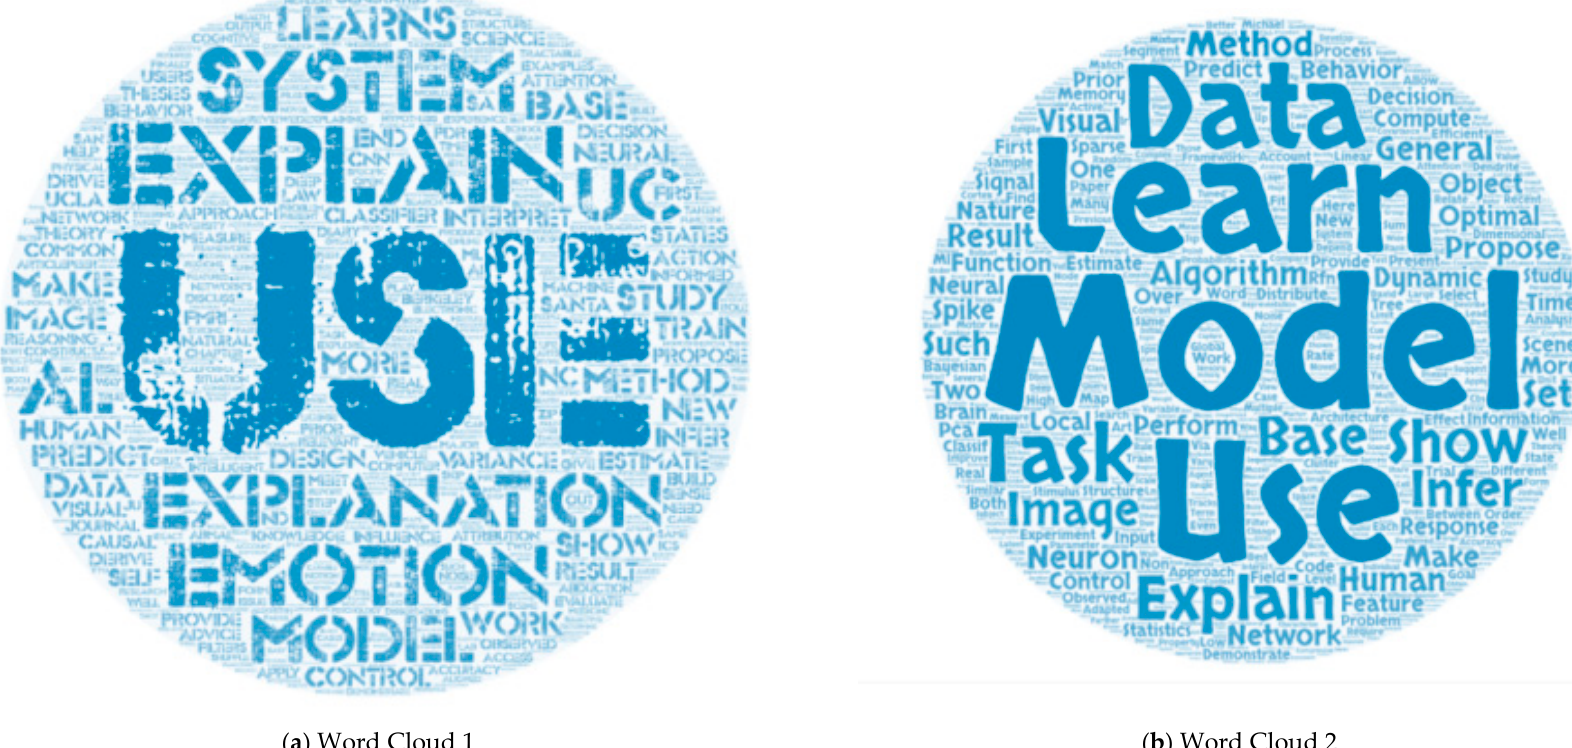
Figure 2. Frequency plot for the term explainability results, ( a ) word cloud 1 and ( b ) word cloud 2.